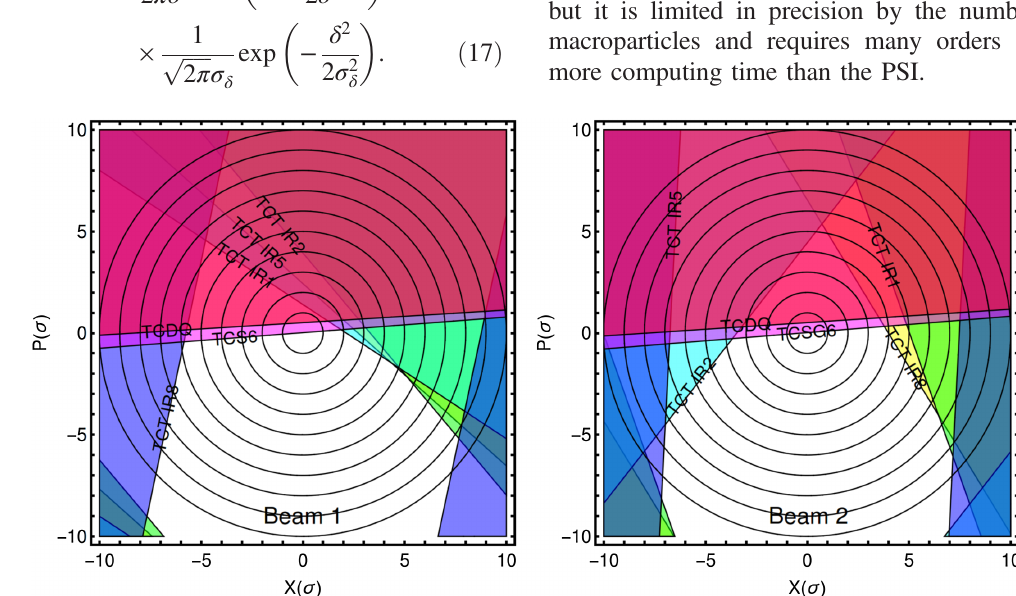
FIG. 6. Example of the on-momentum integration regions defined by Eq. (15) for the dump protection collimators (TCS6 and TCDQ) and all TCTs in B1 (left) and B2 (right) for a setting of 7 . 1 σ for the TCS6 and the TCTs, while the TCDQ is positioned at 7 . 6 σ . The normalized kick θ is also at 7 . 1 σ and a perfect machine is assumed. The circles represent lines of constant phase space density at every σ . The TCDQ is the first collimator seen by the beam, followed by the TCS6 and the TCTs. A perfect optics and β (cid:1) ¼ 60 cm was